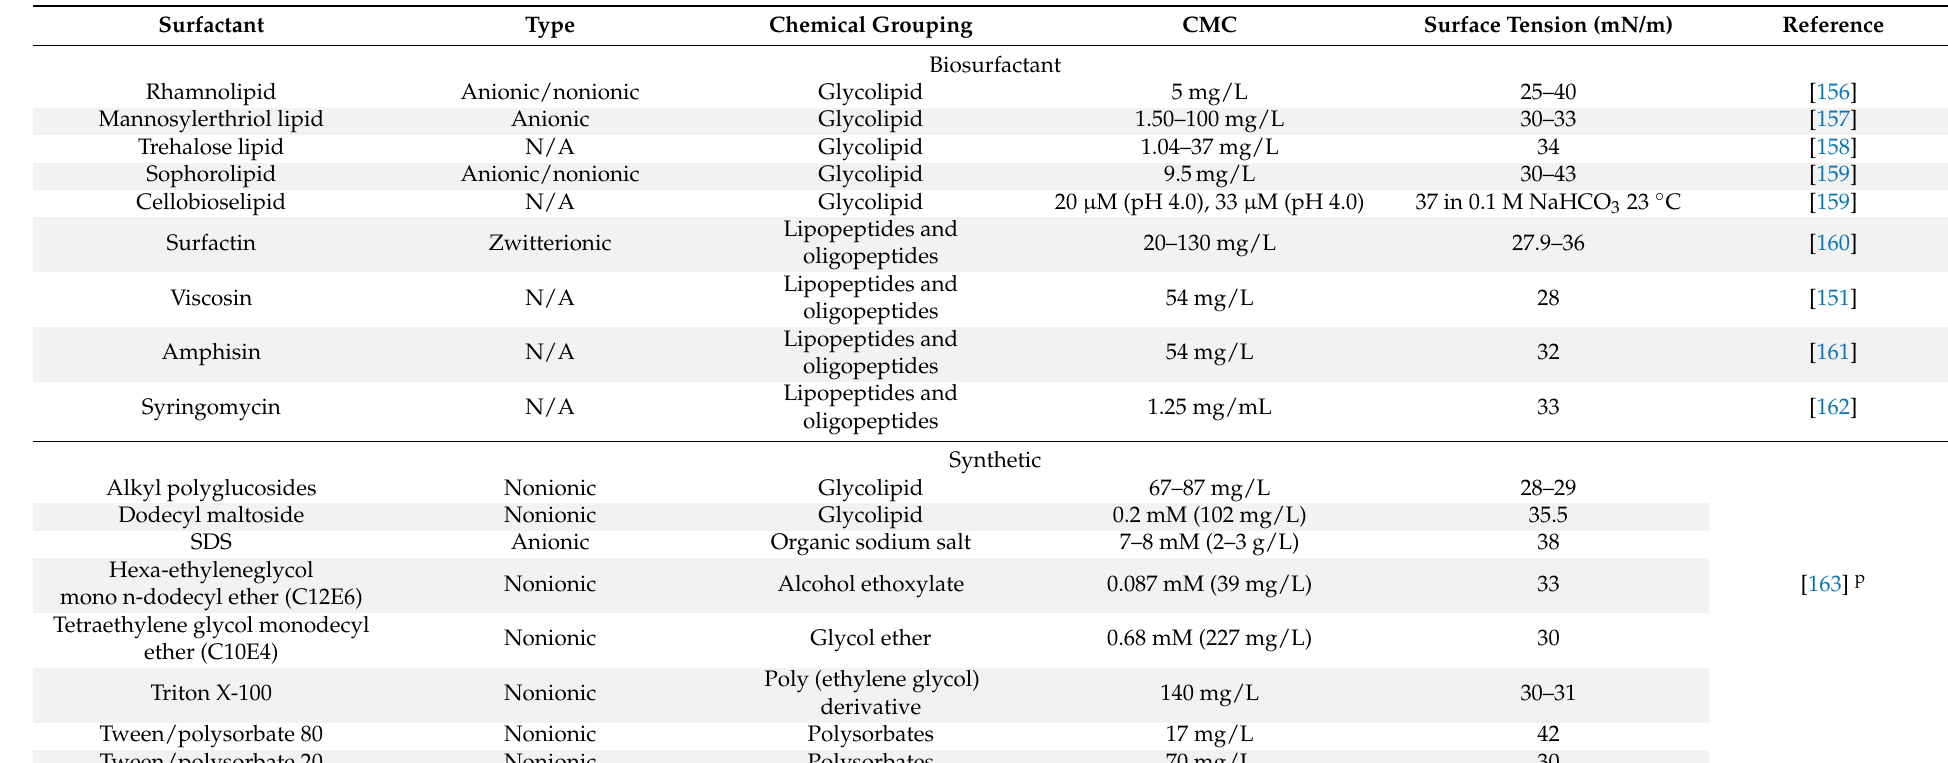
Table 4. Colloidal properties of common synthetic surfactants and